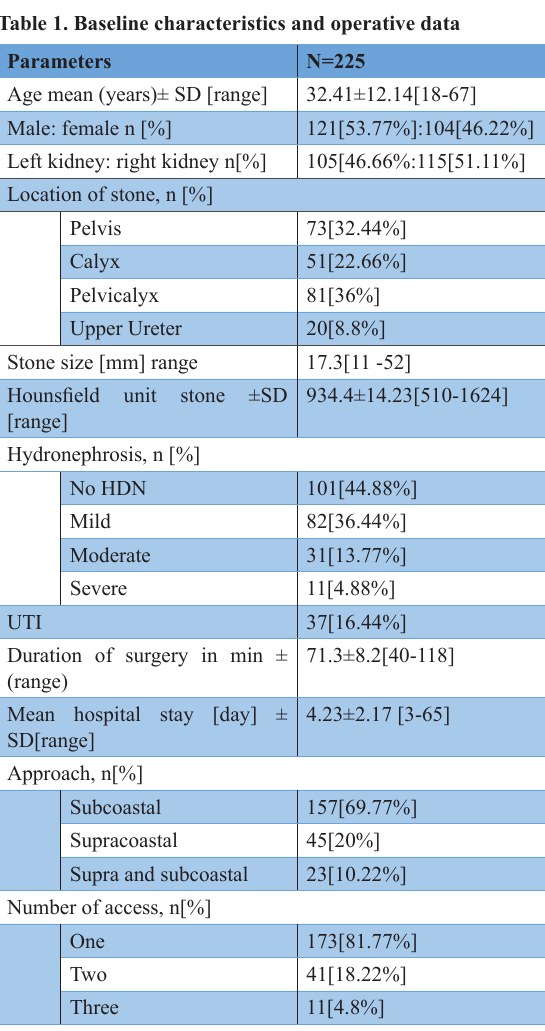
114 right kidneys and 111 left kidneys. Regarding stone